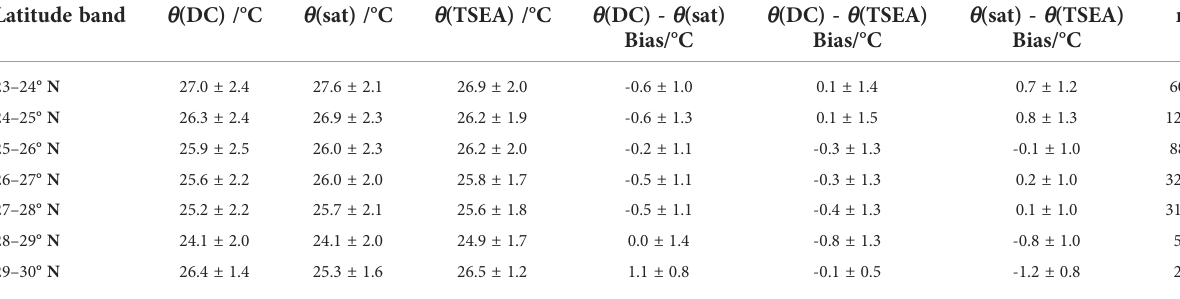
TABLE 2 Mean temperature and bias ( q (DC) - q (sat), q (DC) - q (TSEA) and q (sat) - q (TSEA) by latitude band. Latitude